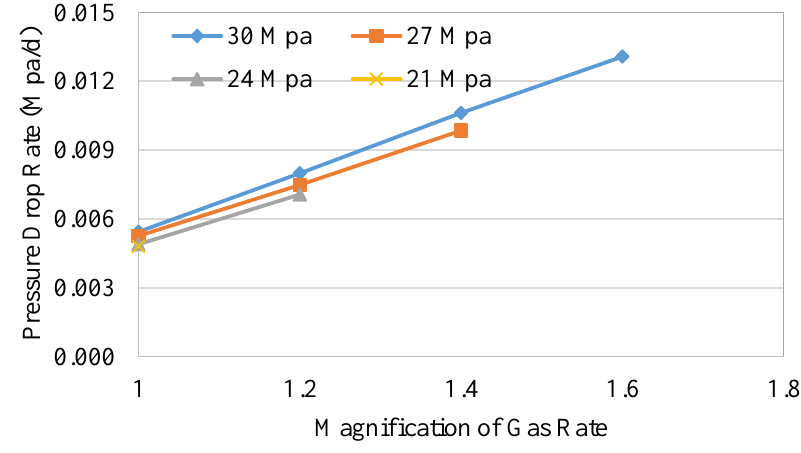
Figure 6—Correlation of pressure drop rate and increment of gas rate of type III well.